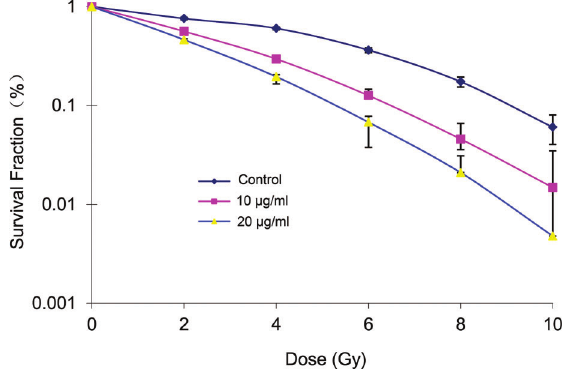
Figure 1 - Cell survival curves of A549 cells following treatment with 0, 10 or 20 m g/mL elemene and exposure to x-ray doses from 0 to 10 Gy.